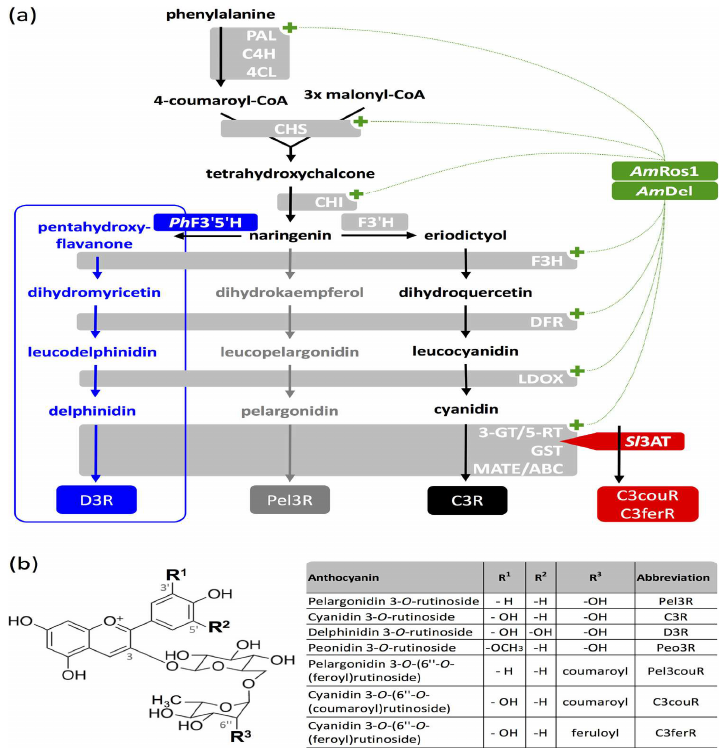
Figure 2. Engineered anthocyanin production in Nicotiana tabacum. ( a ) The biosynthesis pathway of anthocyanins. The expression of an anthocyanin 3-O-rutinoside-4′′′-hydroxycinnamoyl transfer- ase from Solanum lycopersicum (Sl3AT) contributes to the production of aromatically acylated cyanidin 3-O-(6”-O-coumaroyl) rutinoside (C3couR) and cyanidin 3-O-(6′′-O-feruloyl) rutinoside (C3ferR). ( b ) Structures of anthocyanins obtained from tobacco cultures [24]. Reproduced with permission from Appelhagen, Metab Eng .; published by Science Direct, 2018. Several other studies have also been reported regarding key genes to encode acyl- transferase in other plant tissues. In purple carrot, galactosyl was transferred from UDP- galactose to cyanidin by cyanidin galactosyltransferase (UCGalT), which enabled the an- thocyanins to undergo glycosylation and acylation to form stable acylated anthocyanins. The acyltransferase involved in the acylation was produced by the expression of the DcSAT1 gene [30,31]. Moreover, Paulsmeyer et al. [32] reported one anthocyanin acyl- transferase1 (AAT1) in maize, which was the first anthocyanin acyltransferase to be iden- tified in a monocot species. The expression of AAT1 is related to the reduced acylation phenotype in maize, which causes a change in the proportion of acylated anthocyanins and anthocyanins in maize. Evidence also suggests that GRMZM2G387394 is a key gene to encode anthocyanin acyltransferase1 (AAT1) with anthocyanidin malonyltransferase activity in maize.